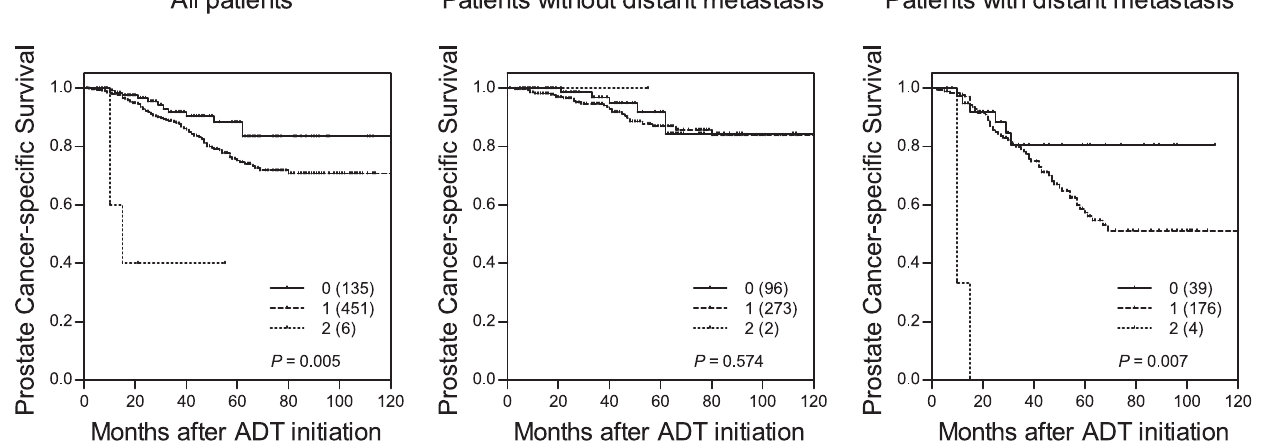
Figure 1. The influence of the genetic loci of interest on PCSM. Kaplan-Meier curves of time to PCSM during ADT for patients with 0, 1, or 2 unfavorable genotypes at the 2 genetic loci of interest in all patients (left), in patients without distant metastasis (middle), or in patients with distant metastasis (right). Numbers in parentheses indicate the number of patients.